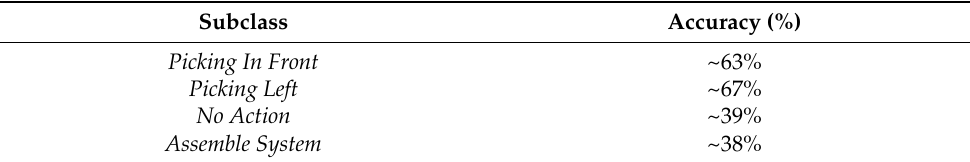
Table 4. Online accuracy results for each subclass.